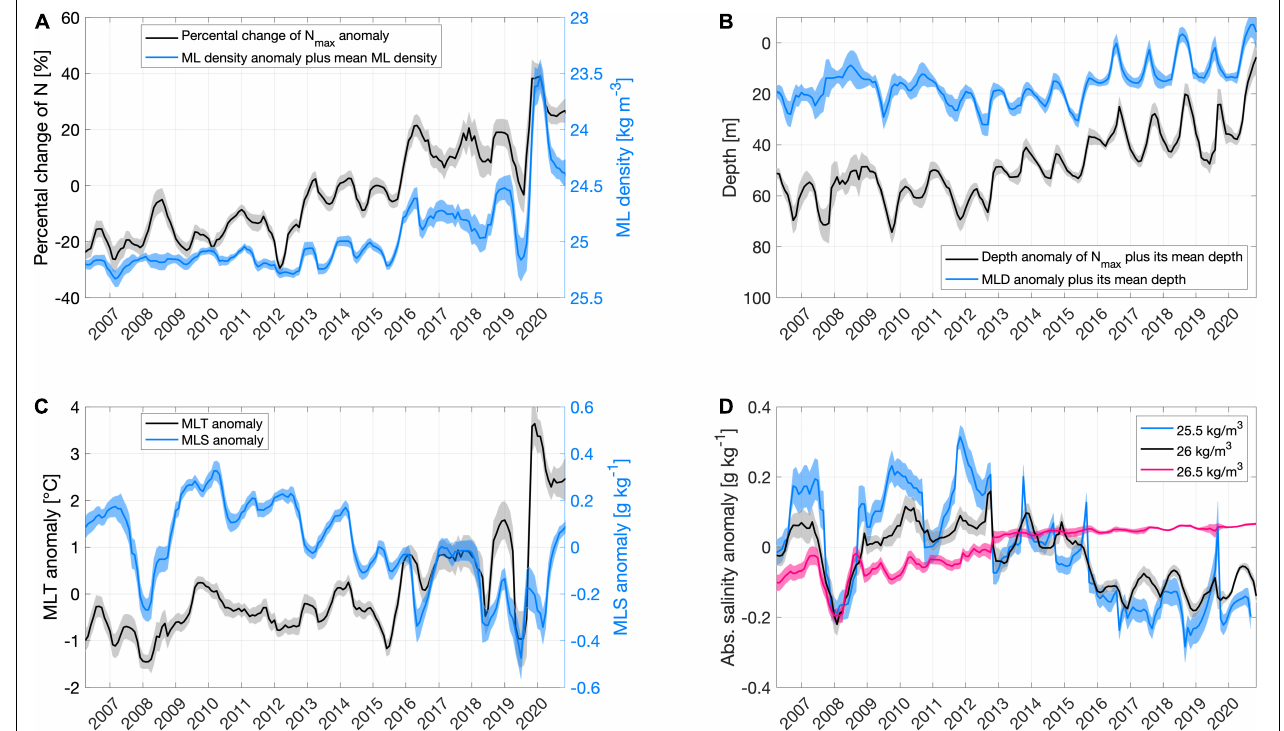
FIGURE 7 | Six months running median of (A) percental change of stratification anomaly of its vertical maximum N max (black line, left y -axis) and mixed layer (ML) density anomaly plus mean ML density (blue line, right y -axis), (B) depth anomaly of the vertical stratification maximum plus its mean depth (black line, left y -axis) and mixed layer depth (MLD) anomaly plus mean MLD (blue line, right y -axis), (C) mixed layer temperature (MLT) anomaly (black line, left y -axis) and mixed layer salinity (MLS) anomaly (blue line, right y -axis) and (D) salinity anomaly on the isopycnal surfaces (i.e., spice anomaly) in SETA (10–20 ◦ S, 5 ◦ W–15 ◦ E). In (D) blue line denotes the 25.5 kg m − 3 isopycnal, black line the 26.0 kg m − 3 isopycnal and pink line the 26.5 kg m − 3 isopycnal. All anomalies are computed relative to the seasonal mean. Shading shows the corresponding 95% confidence interval.